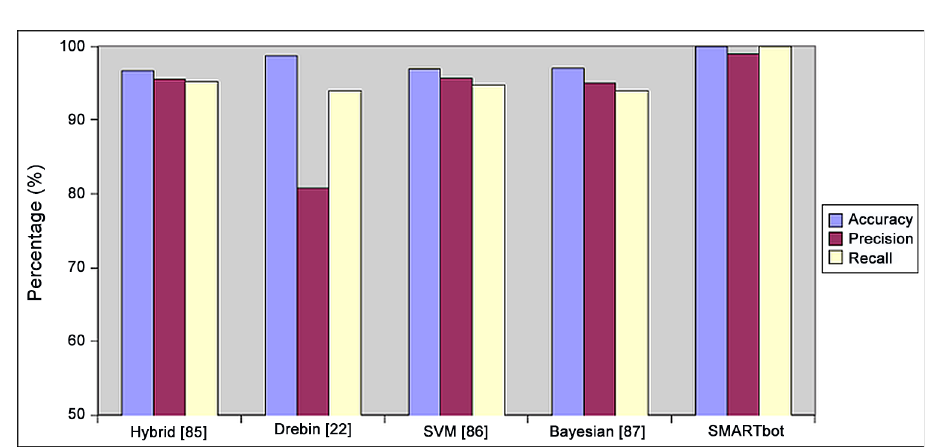
Fig 28. Performance Comparison with existing approaches.